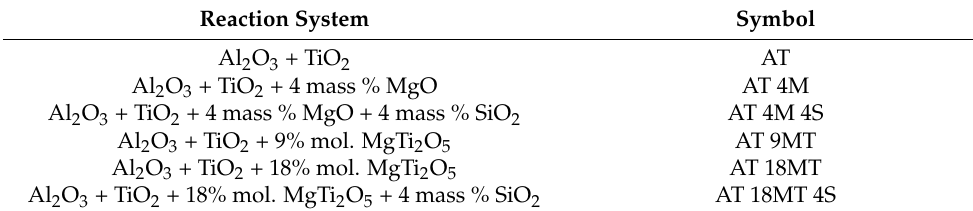
Table 1. Summary of reaction systems used for the investigations. Reaction